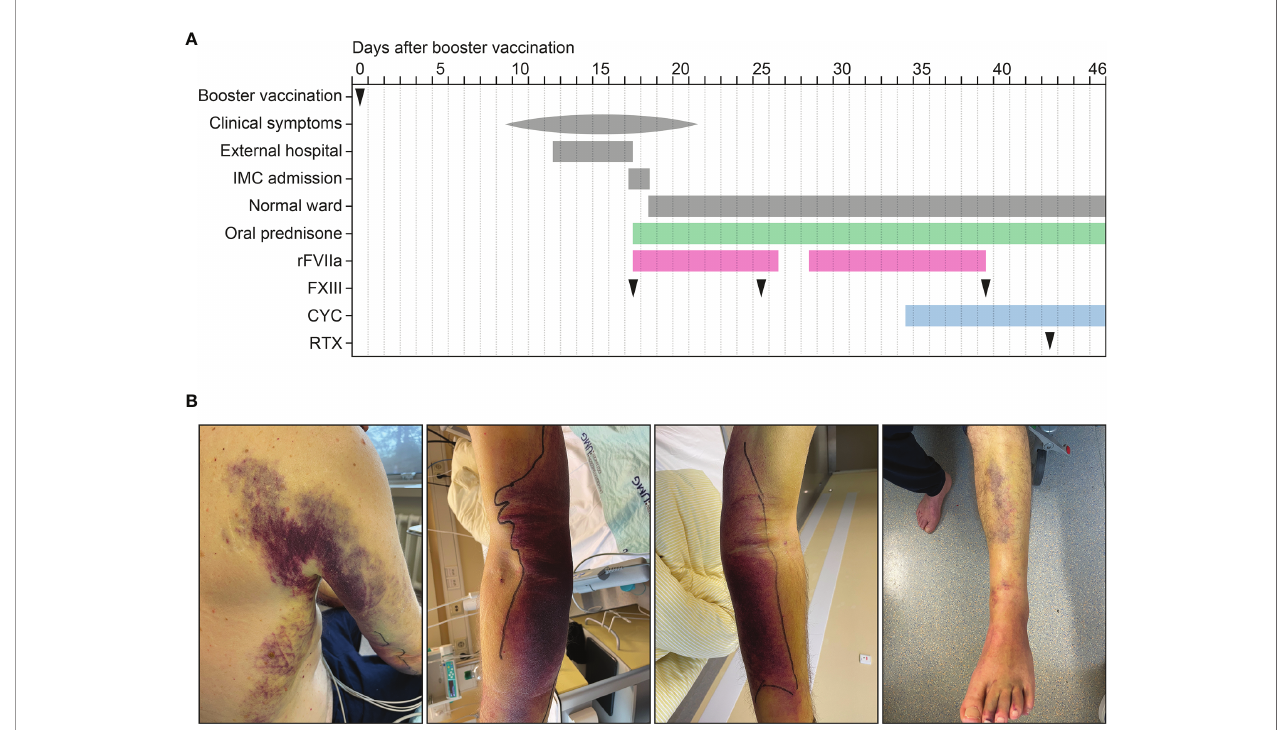
FIGURE 1 | Time course of the case and clinical fi ndings after SARS-CoV-2 booster vaccination. (A) Time course of booster vaccination, onset of symptoms, admission, oral prednisone, substitution of rFVIIa and FXIII, oral CYC and intravenous RTX treatment. (B) Ecchymosis on the upper and lower extremities and the trunk. CYC, cyclophosphamide; FXIII, factor XIII; IMC, intermediate care unit; rFVIIa, recombinant activated FVII; RTX,